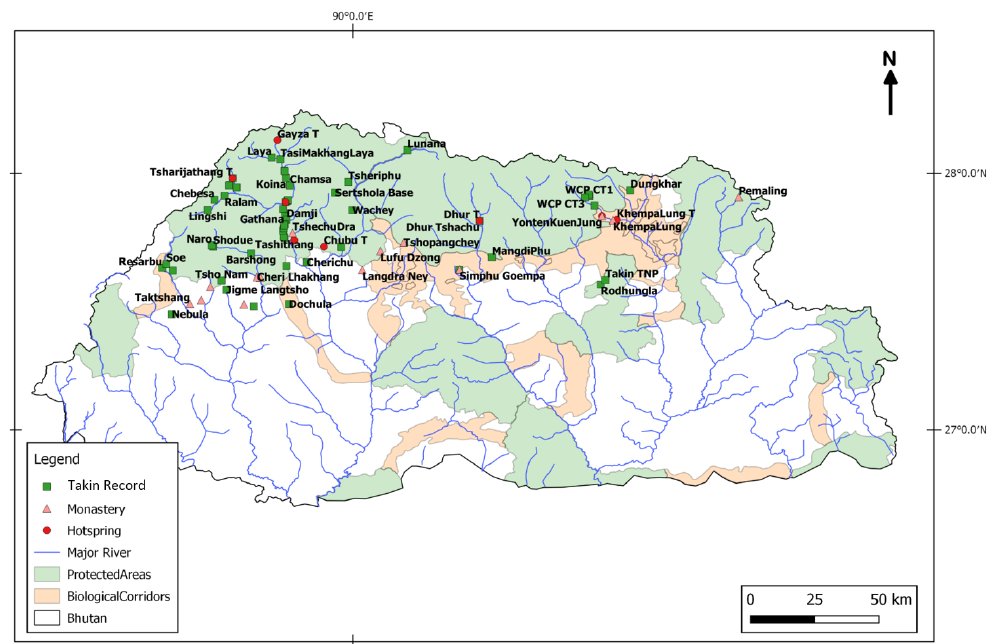
Figure 2. Current distribution of the Bhutan Takin Budorcas whitei along major river valleys, and in close proximity to hot springs (minerals) and Buddhist monasteries (refuge). All the point locations on the map represents either a takin or takin herd observed or reported as well as captured on camera traps in the area.